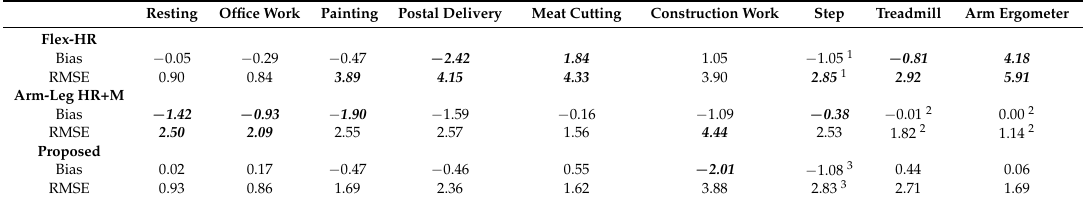
Table 7. Comparison of task specific errors among three methods